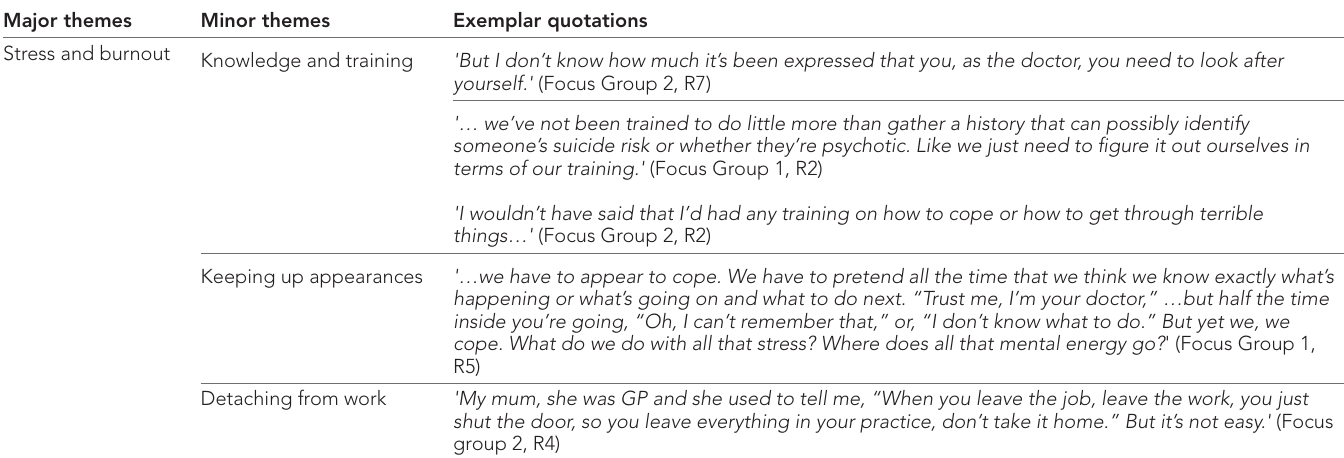
Table 3 Exemplar quotations from participants: stress and